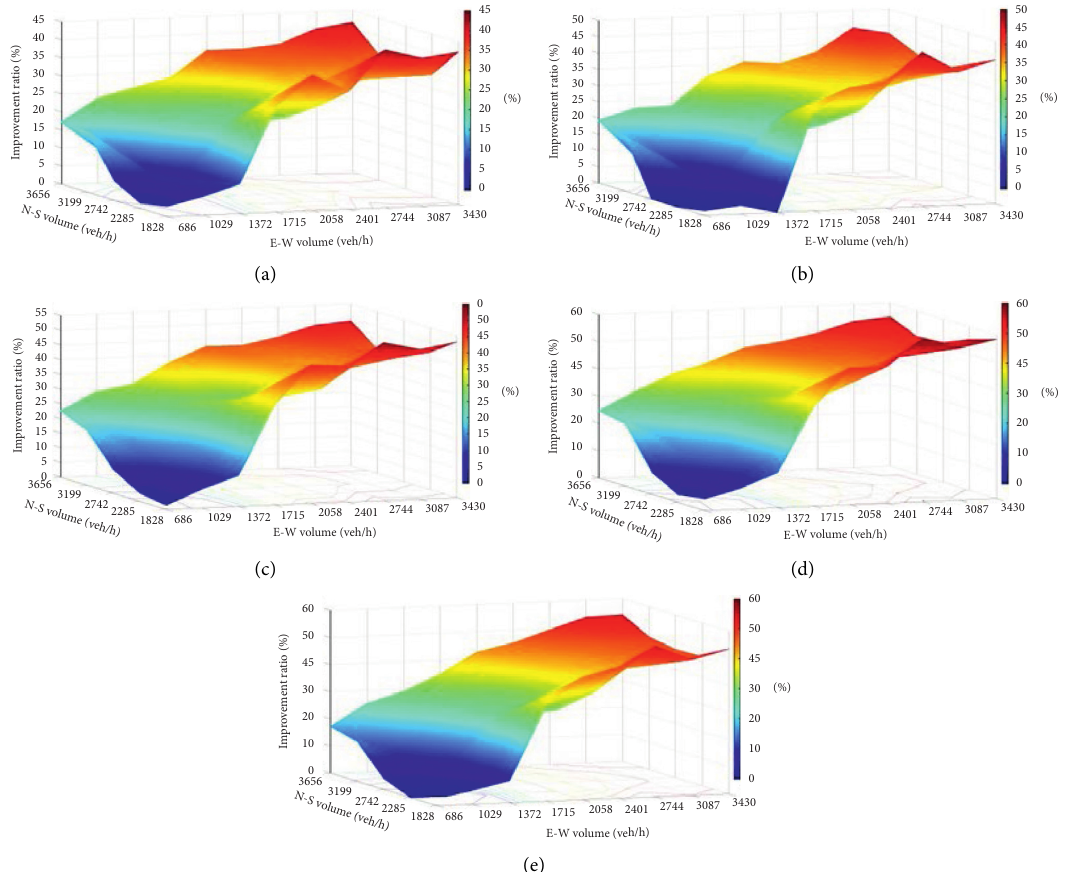
Figure 11: Improvement ratios of the number of stops. (a) Scheme 1. (b) Scheme 2. (c) Scheme 3. (d) Scheme 4. (e) Scheme 5. E-W volume means the same traffic volume of east entrance and west entrance. N-S volume means the same traffic volume of north entrance and south